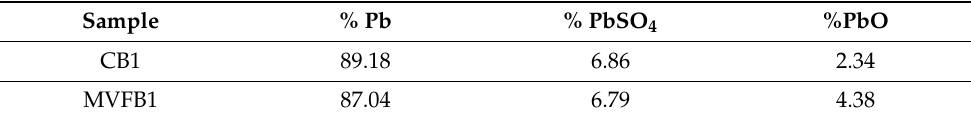
Table 7. Chemical analysis of the negative active materials after formation.